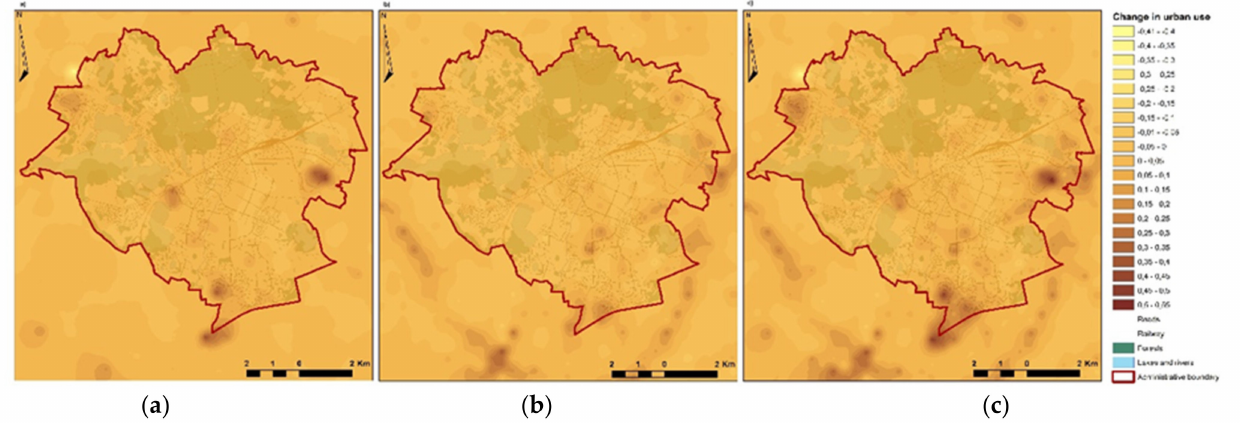
Figure 22. Changes to land use in the years: ( a ): 2005–2010; ( b ): 2010–2018; ( c ): 2005–2018. Source: